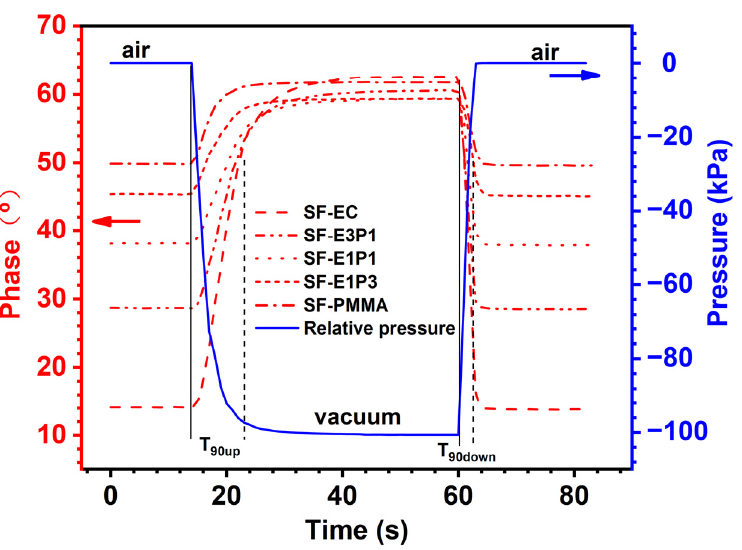
Figure 7. Phase changes of the sensing films with different polymer matrices from air (0 kPa) to vacuum ( − 100 kPa), and from vacuum to air, under ambient temperature in a pressure